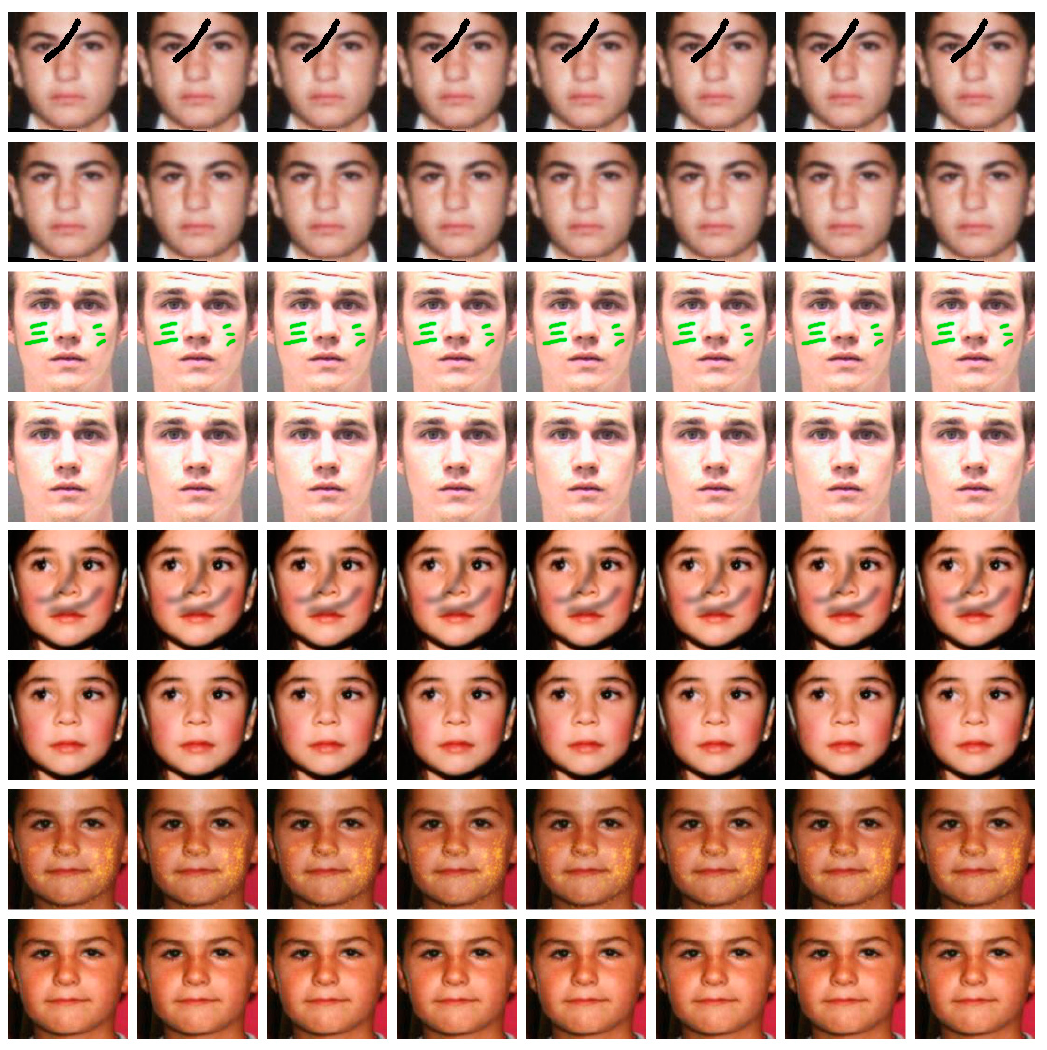
Figure 9. Original graph and pictures with graffiti.